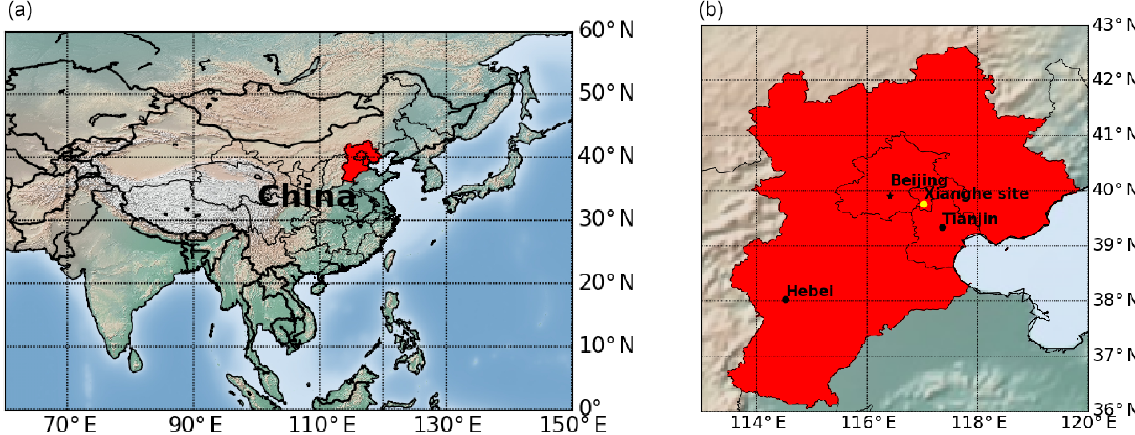
Figure 1. Map of China (a) ; the Beijing–Tianjin–Hebei region is the red shaded area also enlarged in (b) . It is one of the most populous and economically dynamic regions in China. The Xianghe site (yellow spot in b ) is located in Xianghe County, about 50km to the east-southeast of Beijing and 70km to the north-northwest of